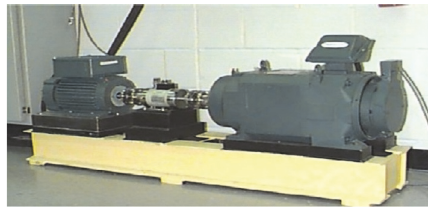
Figure 3: Experimental test rig 1